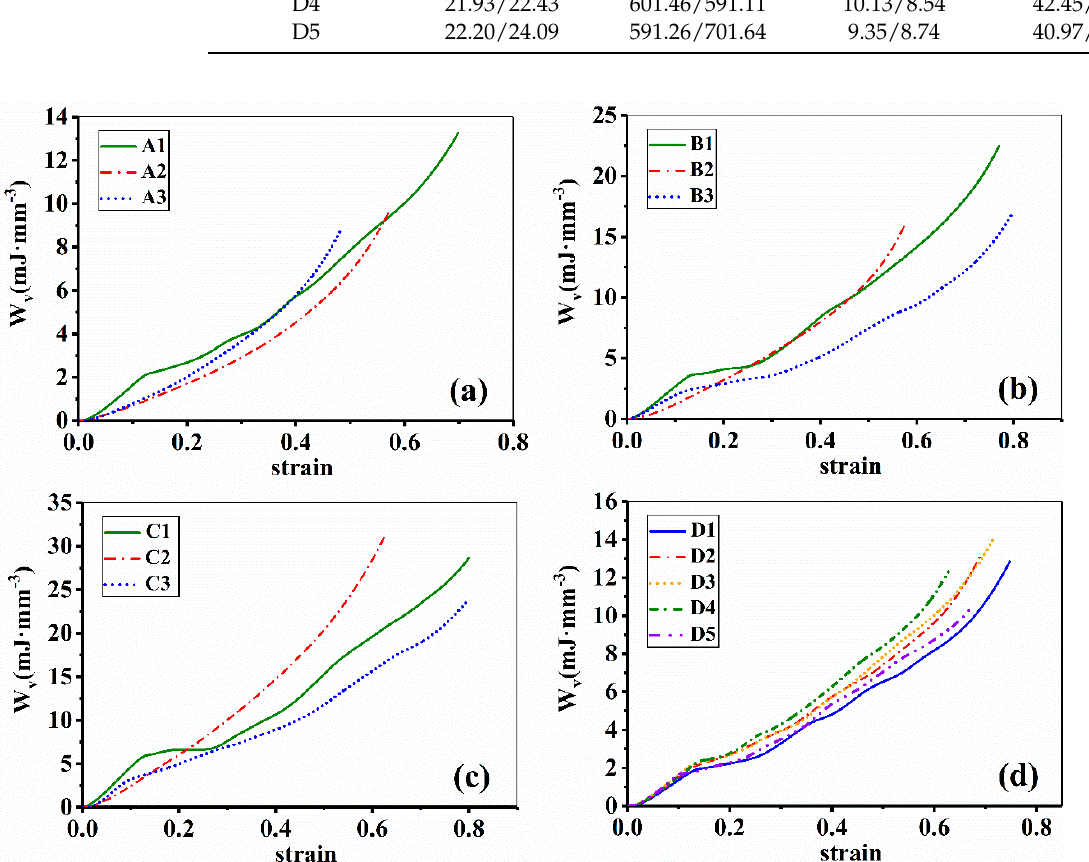
Figure 12. Absorbed energy per unit volume of EP lattice structure samples;( a – d ) represents Group A–D, respectively.